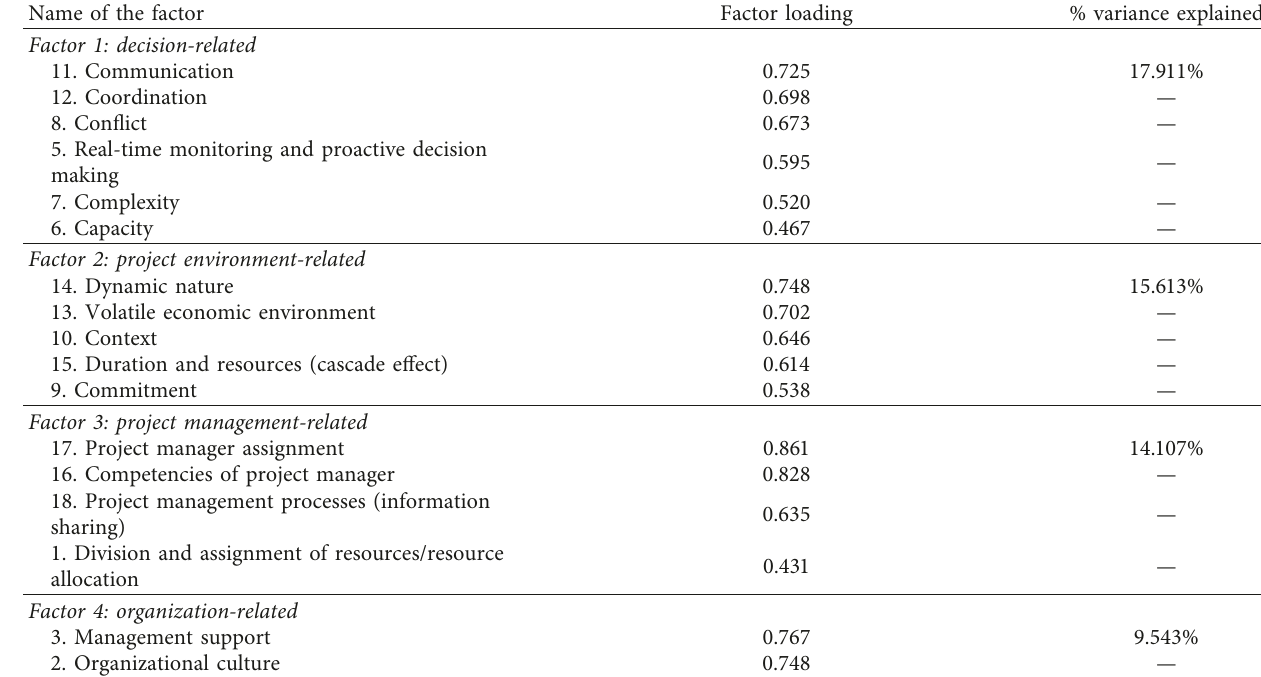
Figure 3: Scree plot. Table 5: Factor analysis: factor loading and the percentage variance explained.